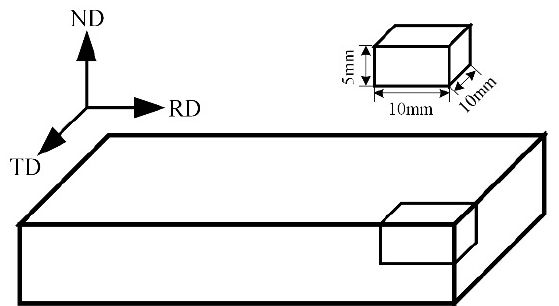
Figure 1. Schematic diagram of rolling plate sampling (ND: Normal Direction, TD: Transverse Direction, RD: Rolling Direction).